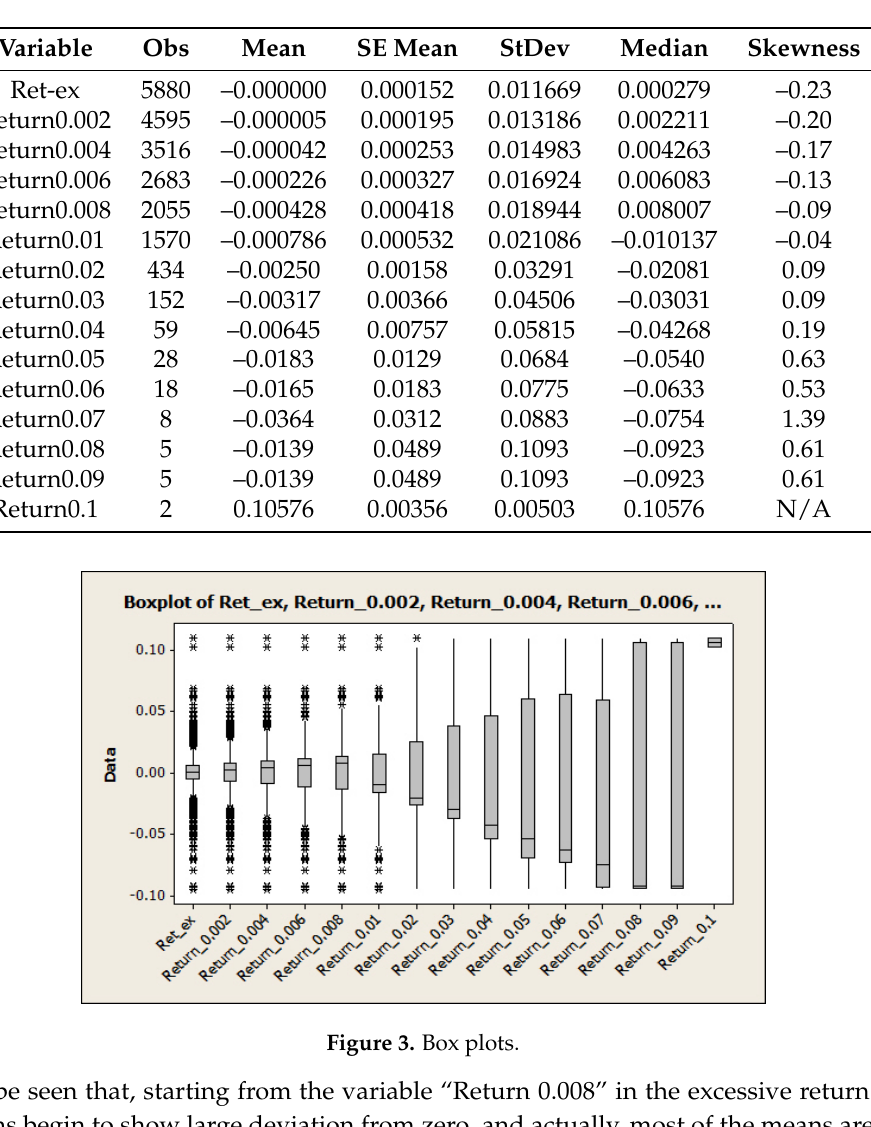
Table 1. Basic statistics on excessive returns.